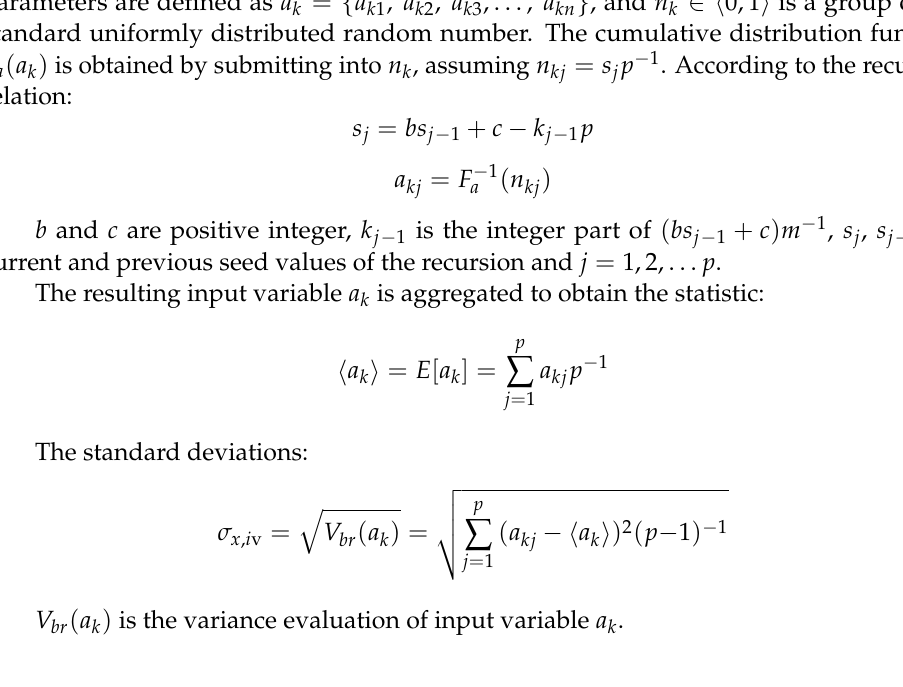
Figure 16. The finite element model of prototype bridge of shaking table test.